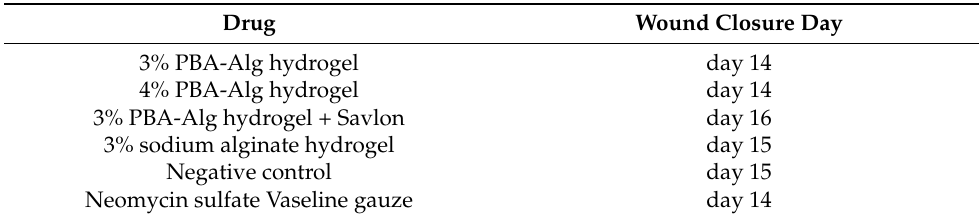
Table 2. Wound closure time.